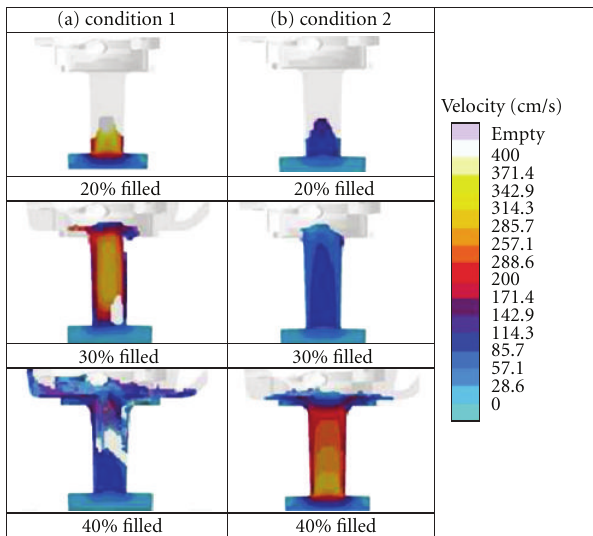
Figure 20: Comparison of velocity behavior at the runner.